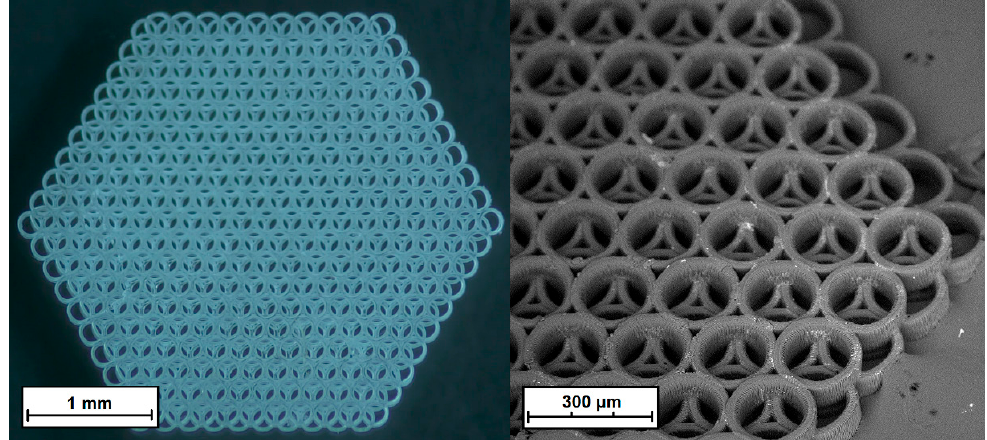
Figure 11. A 3D crosslinked structure (scaffold), prepared as a result of two-photon polymerization of a composition consisting of modified methacrylate-containing PLA, 15 wt. % of OUDM (oligourethanedimethacrylate), and 5 wt. % of the photoinitiator.